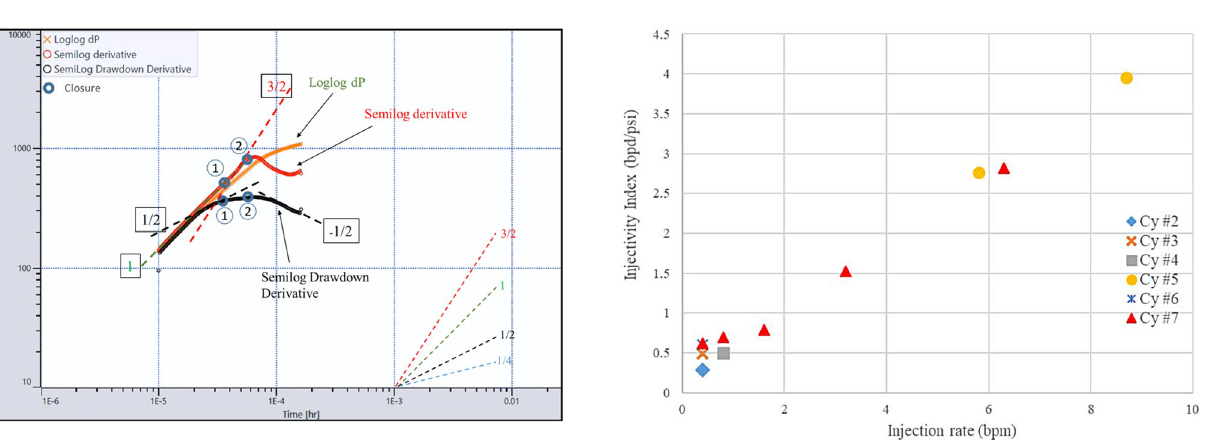
Fig. 26 Injectivity index for DFIT tests performed in Utah FORGE well 58–32. This plot shows the variation of the injectivity index ver- sus the injection